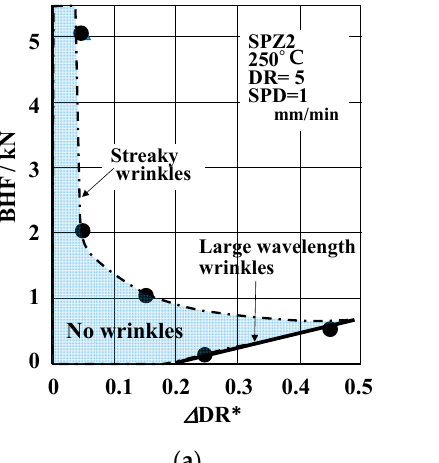
Figure 3. A sequential photograph of the occurrence and growth of wrinkles on the flange part under the conditions of constant punch speed (SPD) and blank holder force (BHF) in a warm deep drawing process using a large blank with a drawing ratio (DR) = 5.